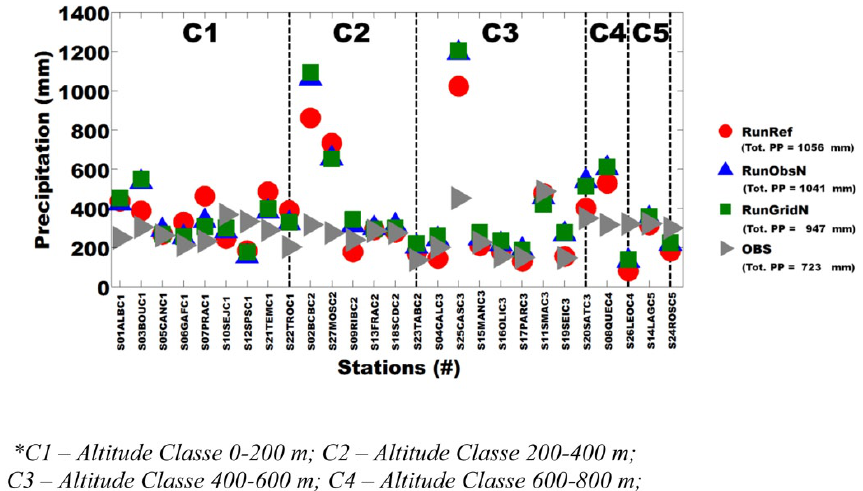
Fig. 6. Monthly accumulated precipitation for the simulation period (mm) over the study domain grouped by altitude classes. The observed amounts are depicted as a grey triangle and for each of the model simulations as RunRef (red circle), RunObsN (blue triangle) and RunGridN (green square). The caption box also shows the total rainfall observed and simulated by the model in each case.